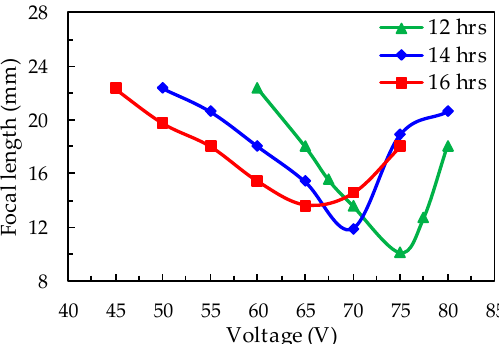
Figure 2. The dependence of the electrically controllable focal lengths of the BPLC microlens array with three different UV exposure time, 12 (green), 14 (blue), and 16 h (red).